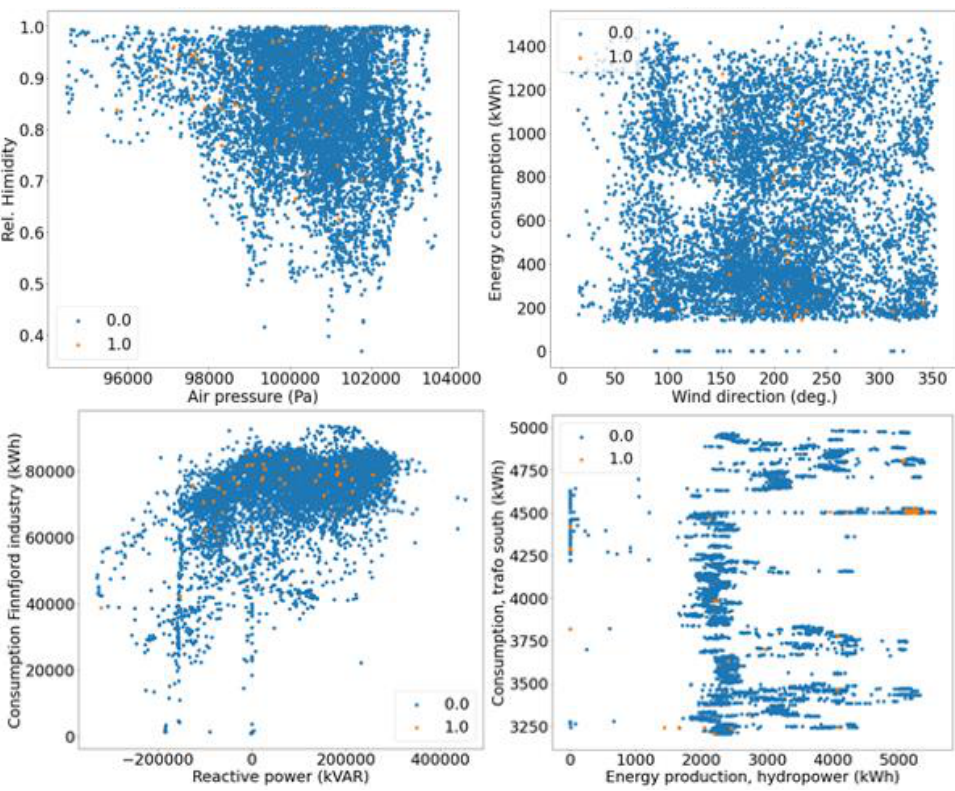
Figure 7. Scatterplot of the two classes for different